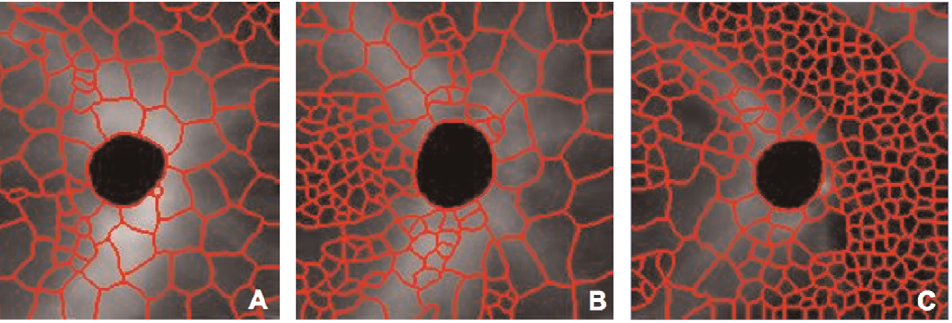
Figure 4. Super pixel segmentation on 3D OCT images. (A) Analysis output in a healthy eye, (B) glaucoma suspect, and (C) glaucomatous eye. Abnormally thin retinal nerve fiber layer is marked with small super